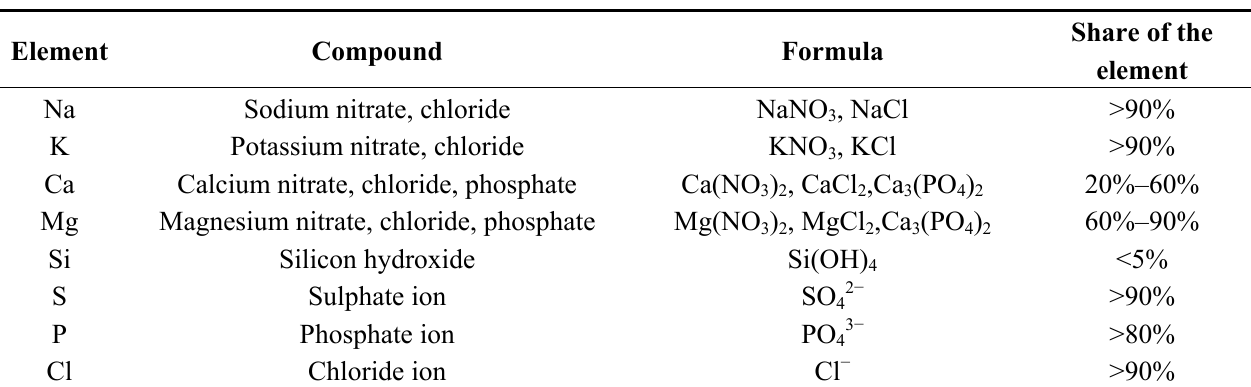
Table 2. Water soluble inorganic materials in high plants